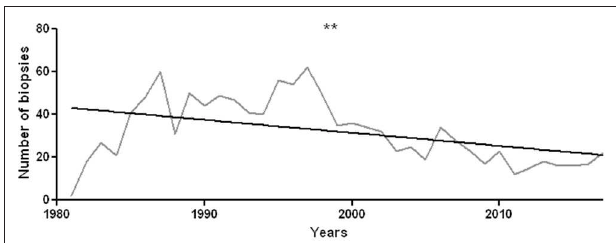
FIGURE 2 | Number of sural nerve biopsies performed during each year from 1981 to 2017. There is a statistically significant decrease in the number of annually performed histological investigations, with r 2 = 0.19 and p = 0.007. ** p <